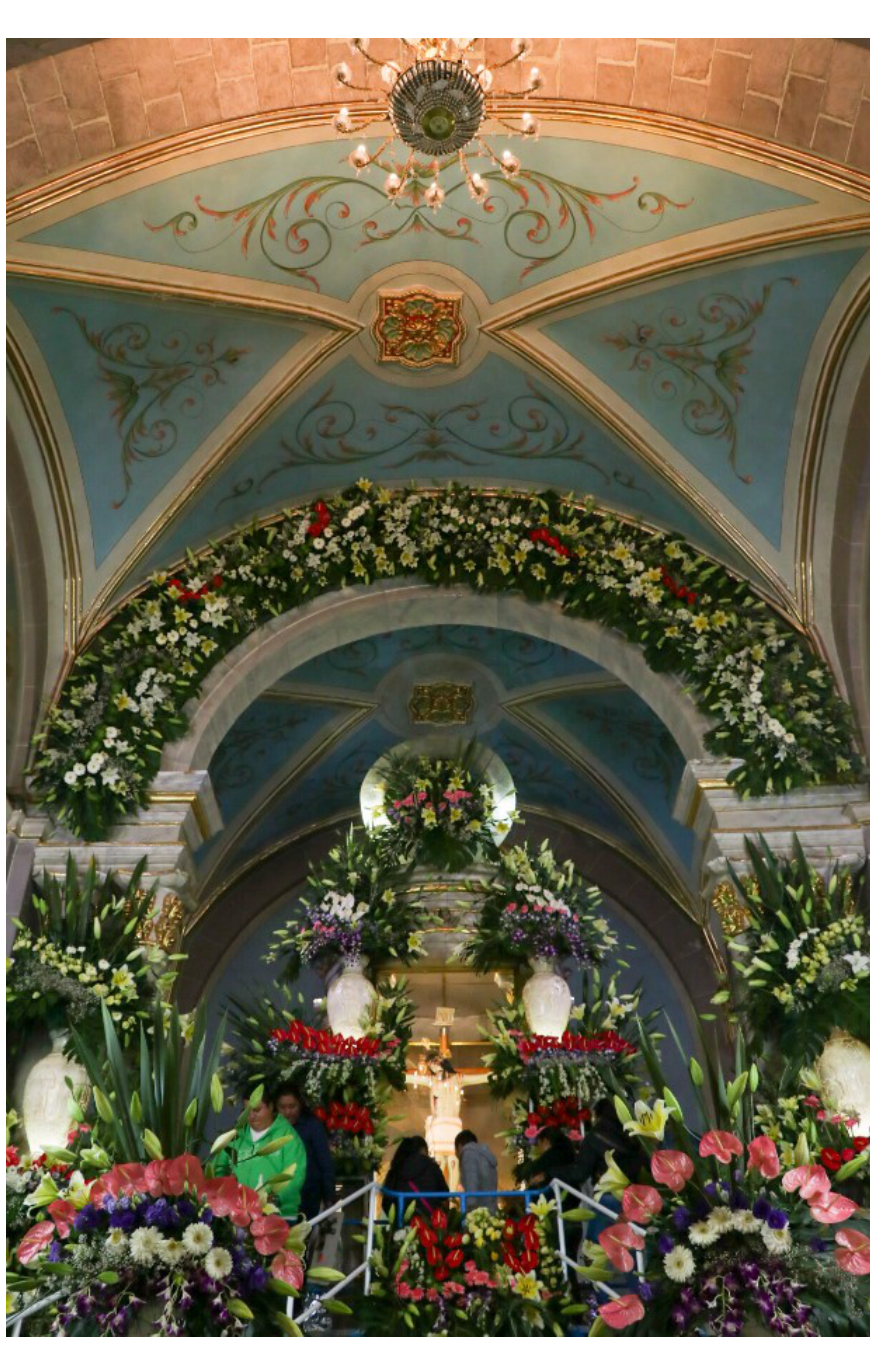
Figure 2 Interior decoration, Parish of Saint Mary Magdalene, Tepexpan. Feast in honor of Our Lord of Graces, 2019. Tepexpan, Acolman, State of Mexico. Copyright: Isaac Trenado